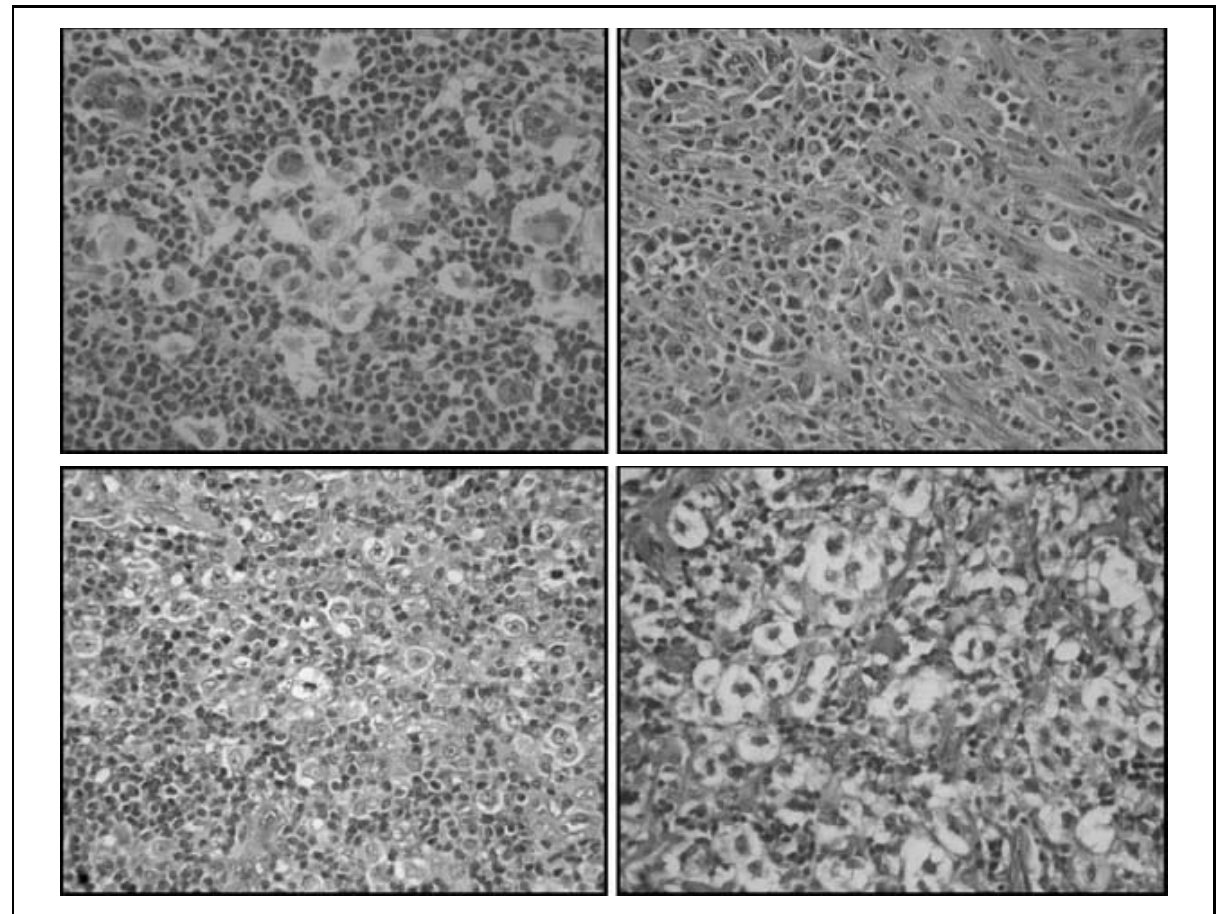
Figura 1 – Graus do linfoma de Hodgkin esclerose nodular. Detalhe dos nódulos celulares. (A) LH EN Grau I – nódulo celular com características de predominância linfocitária. (B) LH EN Grau II – nódulo celular com células de Reed-Sternberg pleomórficas. (C) LH EN Grau II – nódulo celular com características de celularidade mista/depleção linfocitária reticular. (D) LH EN Grau II – nódulo celular com características de depleção linfocitária